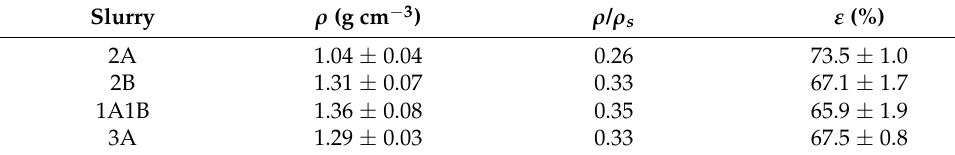
Table 4. Bulk density ( ρ ) and porosity ( ε ) of the produced alumina foams.